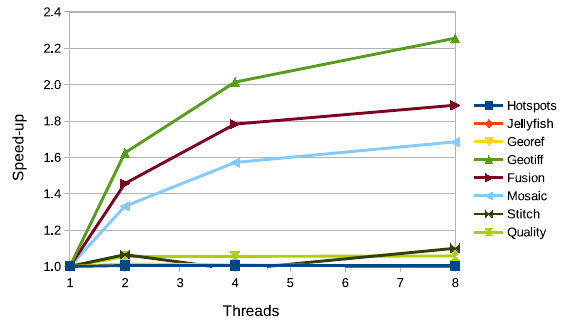
Figure 6: Algorithm performance speed-up in TILE-Gx36